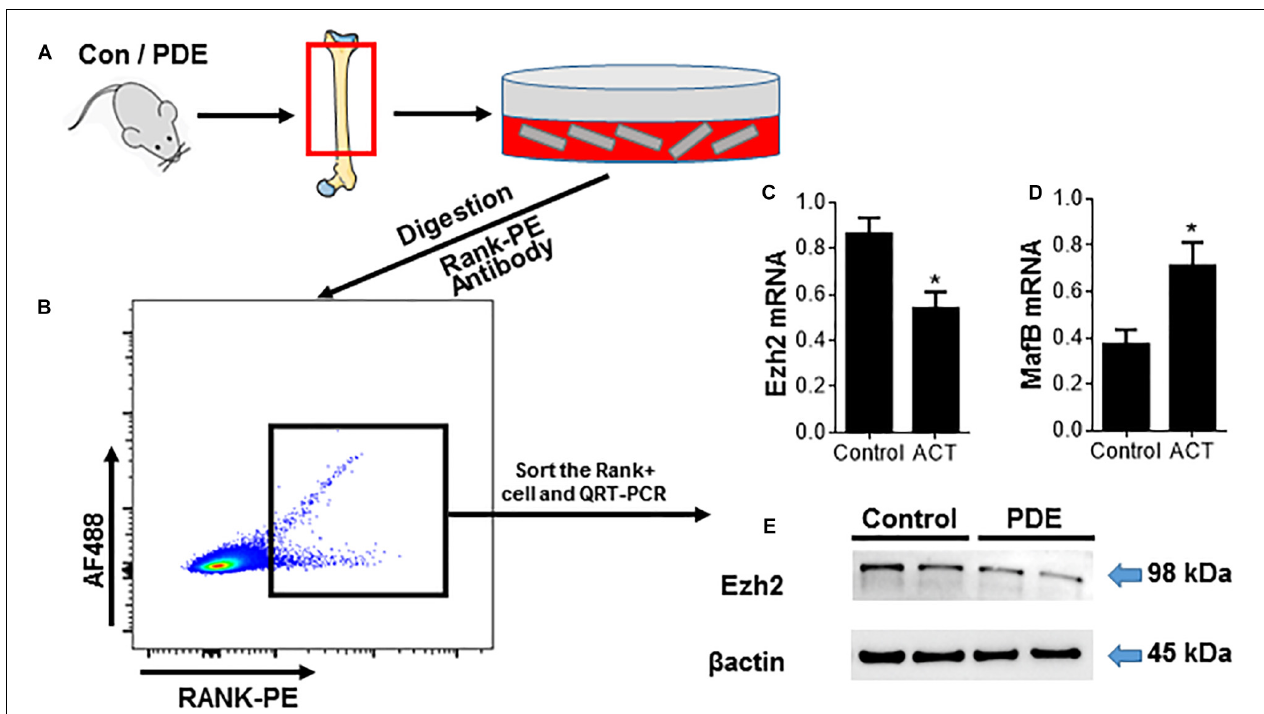
FIGURE 3 | Prenatal dexamethasone exposure decreases Ezh2 expression in osteoclast precursors and attenuates osteoclastogenesis. (A) Diagram showing the procedure for the isolation of OCs from femoral metaphysis (see the detailed description in section “Materials and Methods”). (B–E) RANK+ cells were isolated from femoral metaphyses using the same method as in Figure 2 . (B) Representative flow cytometry plots showing the sorting profile used to separate POCs and OCs in femoral bone from 12-week-old female mouse offspring. Quantitative RT-PCR analyses of Ezh2 (C) and MafB (D) mRNA expression and Western blot analysis of Ezh2 (E) protein expression in the sorted cells are shown. β -Actin serves as control to ensure appropriate loading. * p <